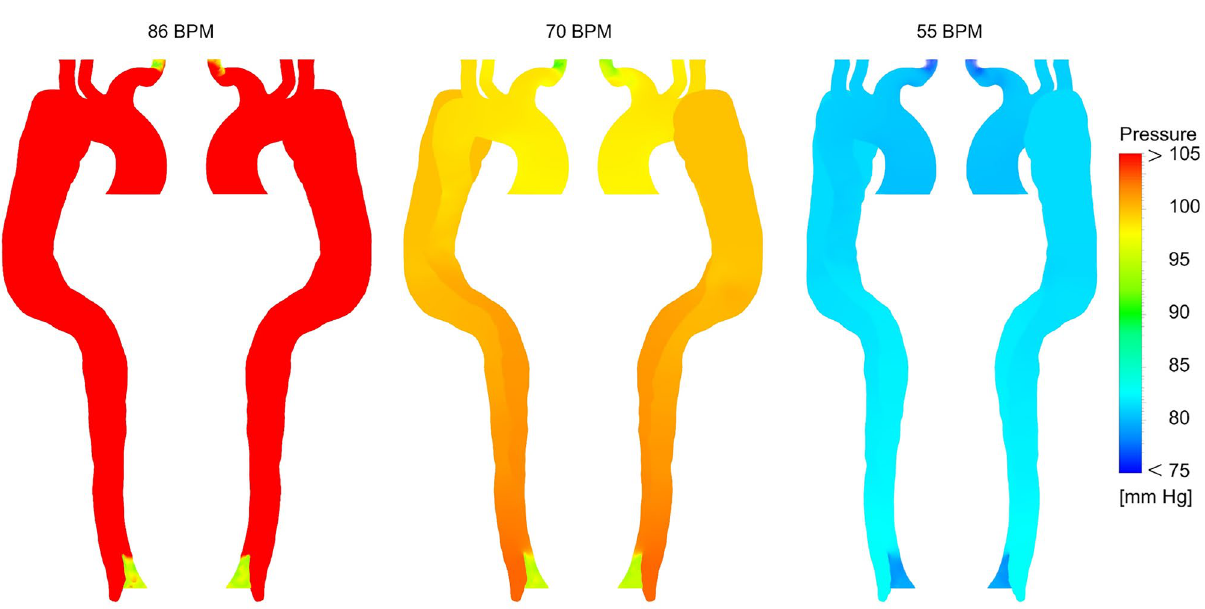
Figure 5. Pressure distribution for three cases during pick systolic blood pressure (the scale bar shown in the figure indicates all